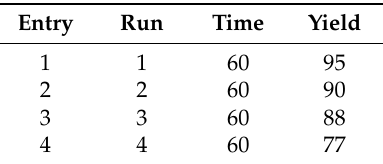
Table 2. Reusability of [Et 3 NH][HSO 4 ] catalyst for model reaction 4a